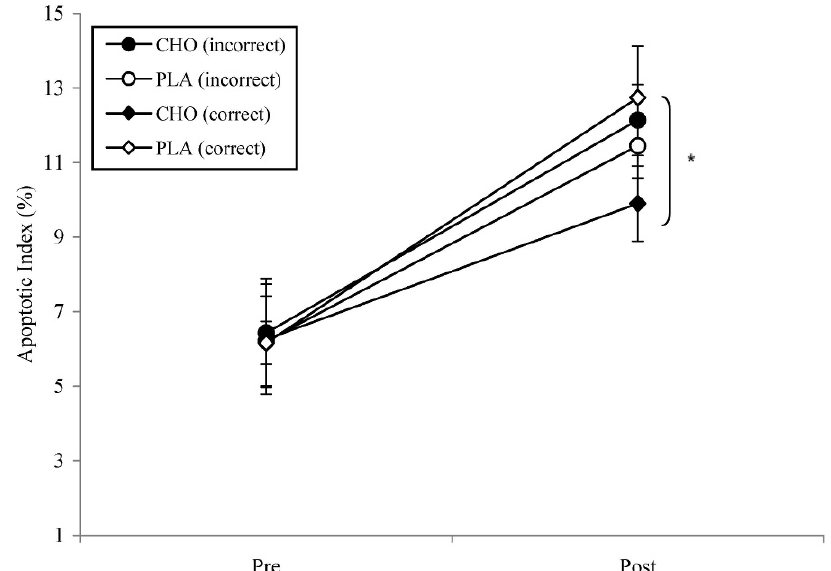
Figure 3 - Apoptotic index (%) in lymphocytes before (Pre) and after (Post) 60-min of cycle ergometry at , 80% VO 2peak in carbohydrate (CHO) and placebo (PLA) trials. Data are presented as means and standard deviations (bars). One trial was carbohydrate supplemented (CHO), and the other was a placebo trial (PLA). Half of the participants had correct cognitive awareness of the supplementation type (correct) while the other half believed they were receiving the opposite supplementation (incorrect). * indicates significant increase with exercise compared to the resting condition (P ,